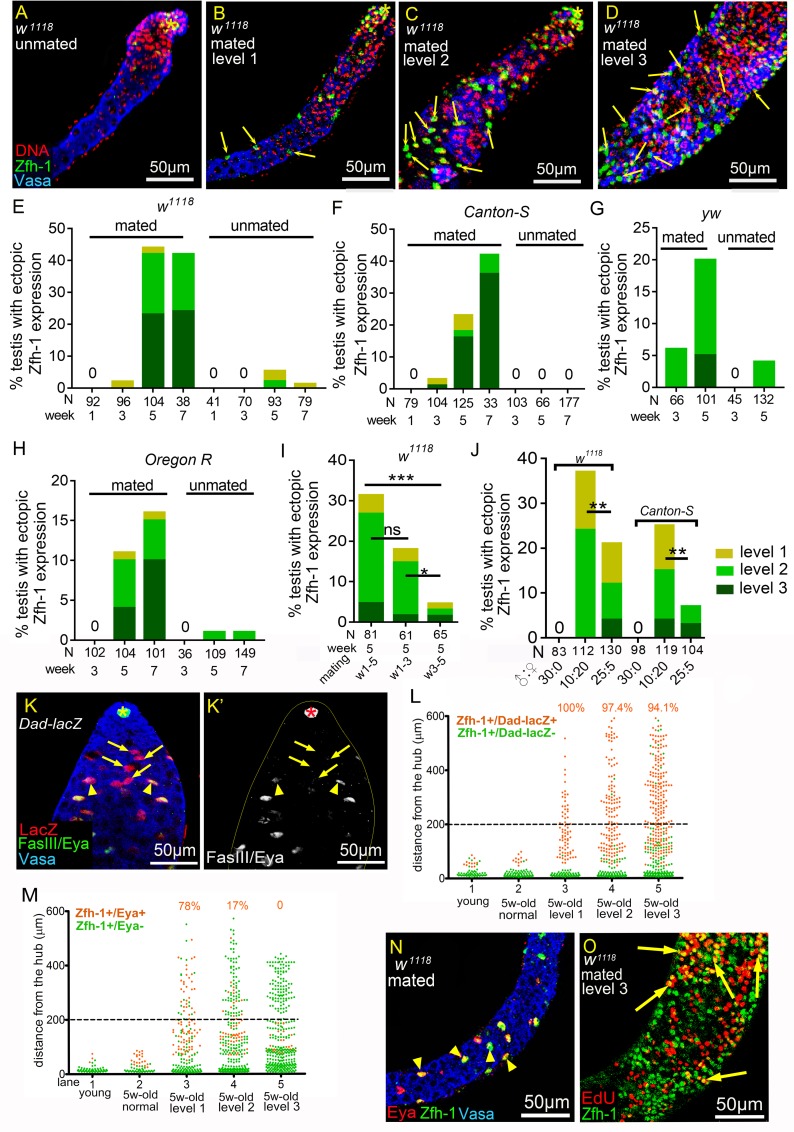
Reproduction disrupts cyst cell differentiation.(A-D) 5w-old w1118 testes immunostained for Zfh-1 (green), co-stained for Vasa (blue), and DNA (red). Asterisks mark the hubs. Arrows indicate ectopic Zfh-1-positive cells. (A) Normal testis from an unmated male (30 vs. 0). Zfh-1-positive cells and early germ cells were located near the hub. (B-D) Testes from mated w1118 males (10 vs.20), exhibiting ectopic Zfh-1expression at level 1 (B), level 2 (C), and level 3 (D). (E-H) Percentages of testes with ectopic Zfh-1-positive cells from the males at different ages. Numbers of the testes scored are shown in the parentheses. (E-H) Testes from mass-mated (10 vs. 20) or unmated (30 vs. 0) males of w1118 (E), Canton-S (F), yw (G), and Oregon R (H) at different ages. (I) Testes from 5w-old w1118 males mated with females (10 vs. 20) for five weeks (week 1–5), the first three weeks (week 1–3), or the last three weeks (week 3–5). (J) Testes from 4w-old w1118 and Canton-S males mated to females with the ratios of 30:0, 10:20, and 25:5. P-values in I and J were calculated with Chi-squared test. ns: p>0.05, *p<0.05, **p<0.01, and ***p<0.001. (K and K’) 3-day-old Dad-lacZ testis immunostained for β-galactosidase (red in K), co-stained for FasIII and Eya (green in K, and white in K’) and Vasa (blue in K). Arrows indicate the LacZ-positive and Eya-negative cyst cells. Arrowheads mark the cells double positive for LacZ and Eya. Asterisks indicate hubs. (L and M) Graphs showing the distance of Zfh-1-positive cells to the hub in the mated testes from Dad-lacZ (L) and w1118 males (M). Each dot indicates a single Zfh-1-positive cell. Ectopic Zfh-1-positive cells are defined as cells 200 μm away from the hub (dash line). Percentages of the double positive cells among the total ectopic Zfh-1-positive cells are shown at the top of each column. (N) A testis from mated 5w-old w1118 exhibiting ectopic Zfh-1 expression in differentiated cyst cells. Arrowheads mark the ectopically expressed Zfh-1 (green) in Eya (red)-positive cells away from the hub (large, Vasa-positive cells). (O) EdU labeling of a testis displaying level 3 ectopic Zfh-1 expression from mated 5w-old w1118 males. The arrows indicate the double-positive cells for EdU (red) and Zfh-1 (green) away from the hub. Mass-mating schemes were conducted for all experiments.